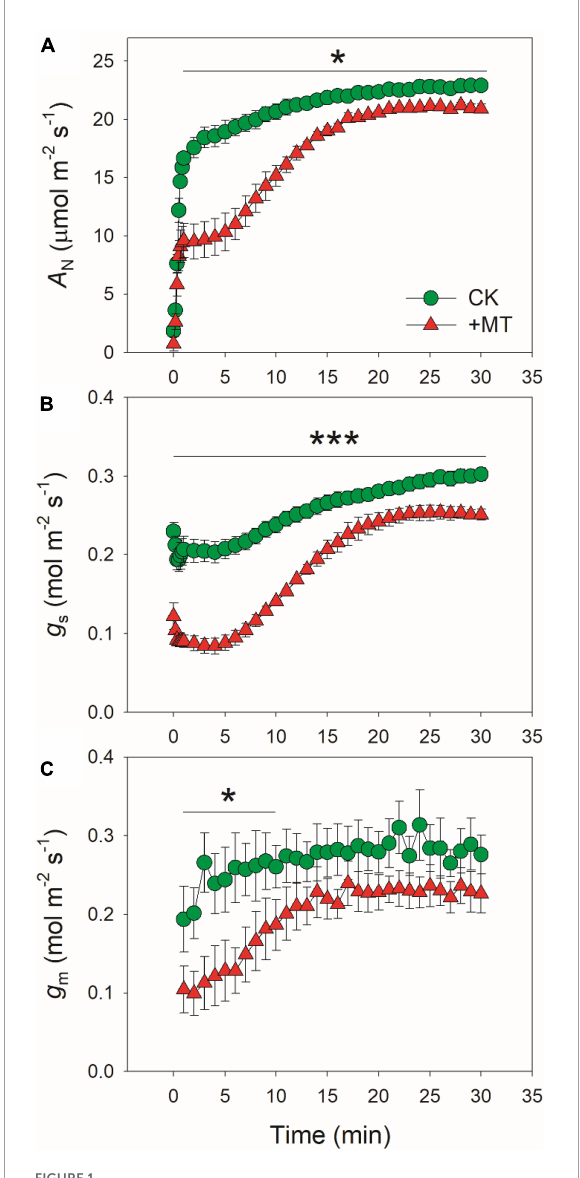
FIGURE1 Effects of exogenous melatonin (MT, 100 µ M) on the induction response of net CO 2 assimilation rate [AN, (A) ], stomatal conductance [gs, (B) ], and mesophyll conductance [gm, (C) ] after transition from 50 to 1500 µ mol photons m − 2 s − 1 . Values are means ± SE ( n = 5). Asterisk indicates a significant difference between CK and MT-treated